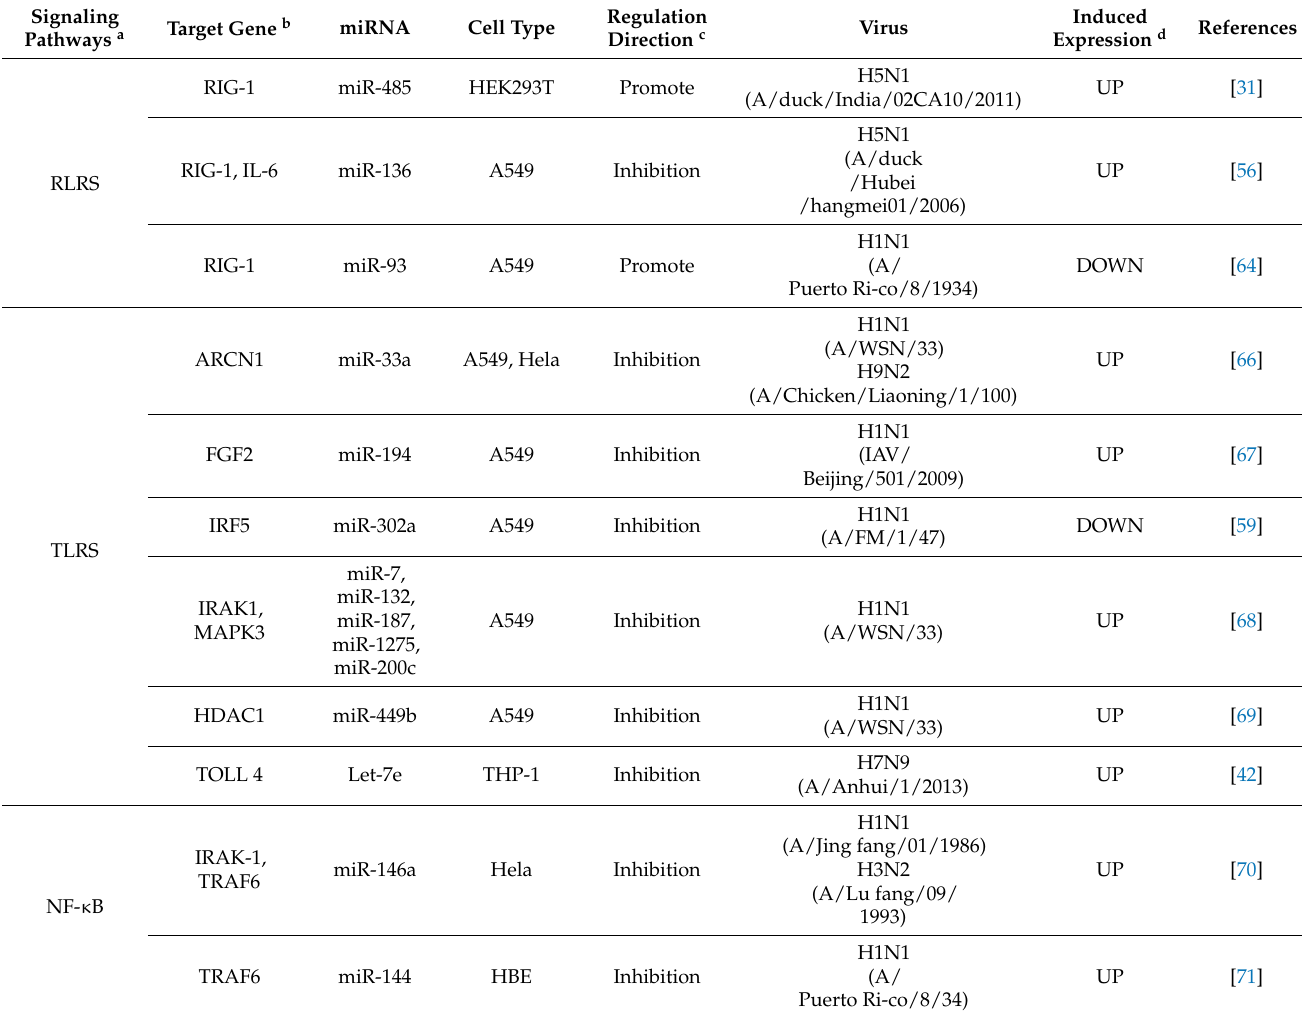
Table 2. Host miRNAs indirectly regulate influenza A virus